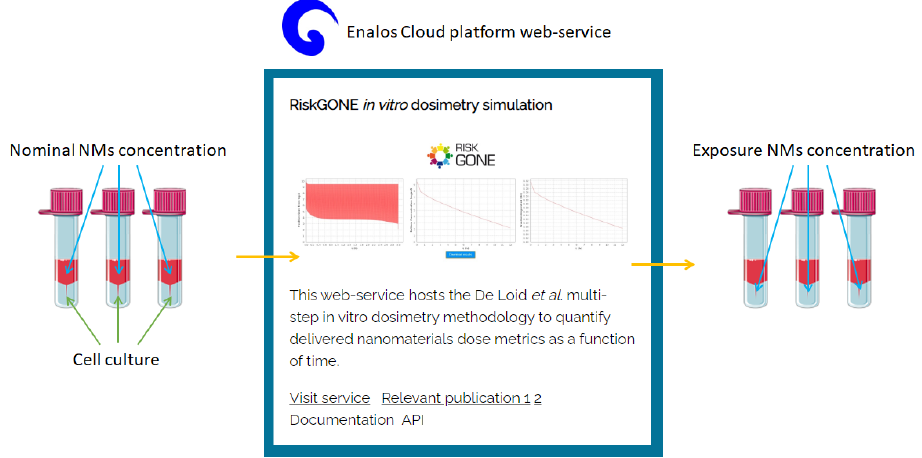
Figure 1. The RiskGONE instance of the Enalos Cloud Platform, showing the RiskGONE “in vitro dosimetry” simulation web application. Clicking on the application opens the model webpage, which consists of a description of the model and step-by-step instructions regarding the inputs needed: http://enaloscloud.novamechanics.com/riskgone/InVitroDosimetry/ (accessed on 31 October 2022).